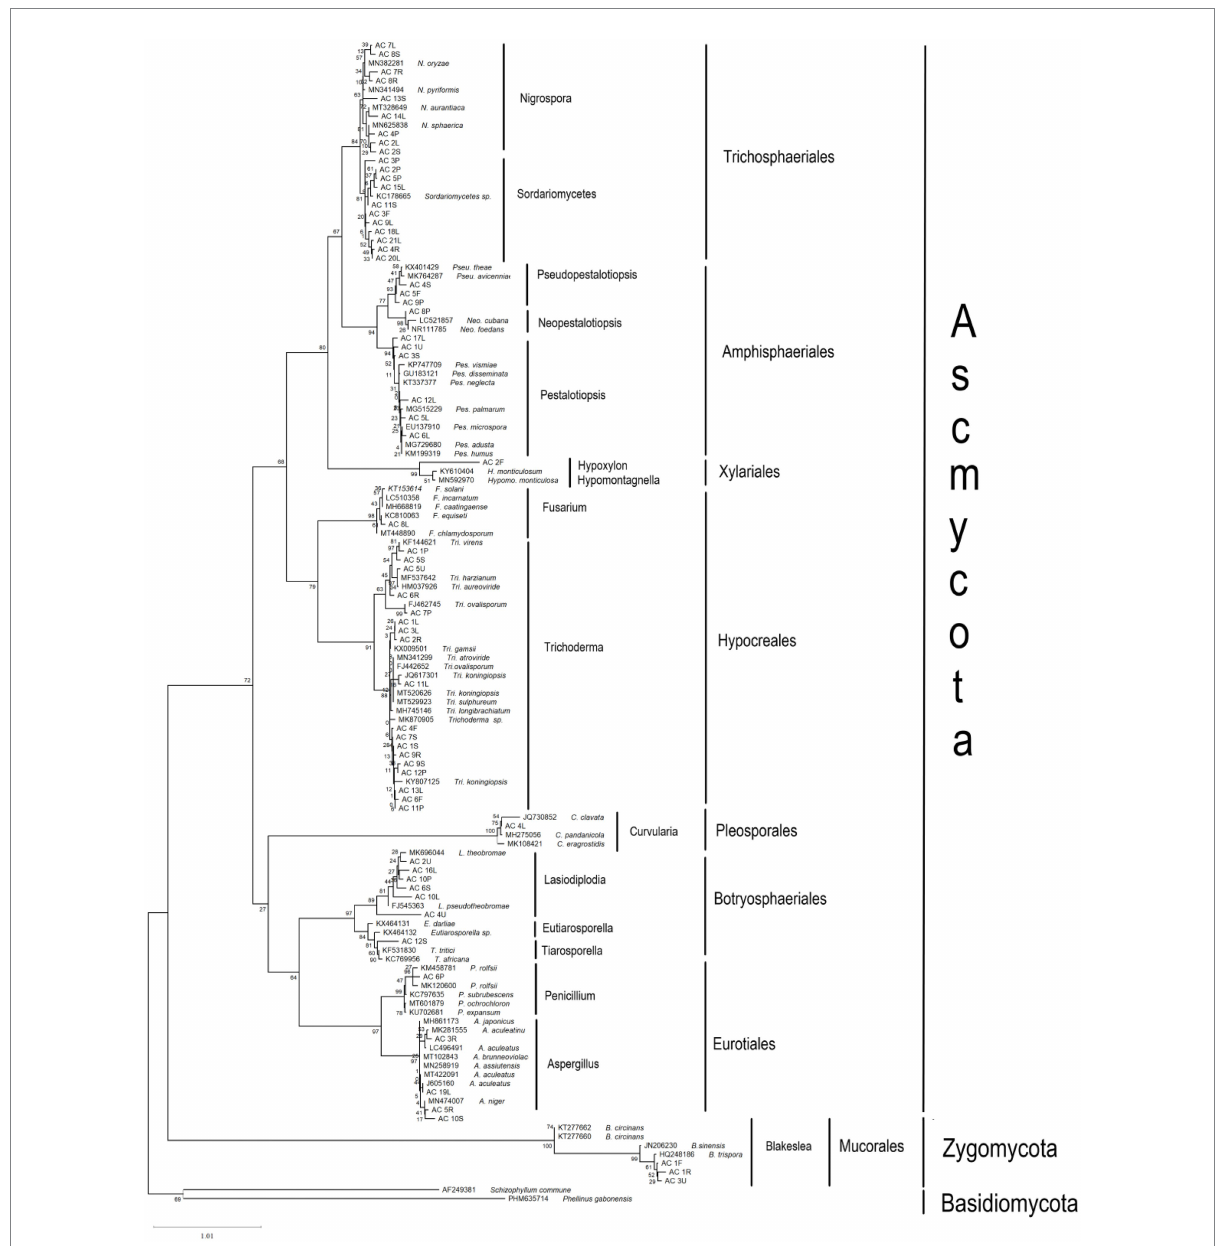
FIGURE 1 Maximum likelihood (ML) phylogenetic tree based on rDNA ITS sequences of endophytic fungal isolates and fungal ITS sequences from the GenBank. ML tree was constructed using the Kimura 2-parameter (K2) model and gamma distributed (+G) model. All positions containing gaps and missing data were included for analysis. Clade supports were calculated based on 1,000